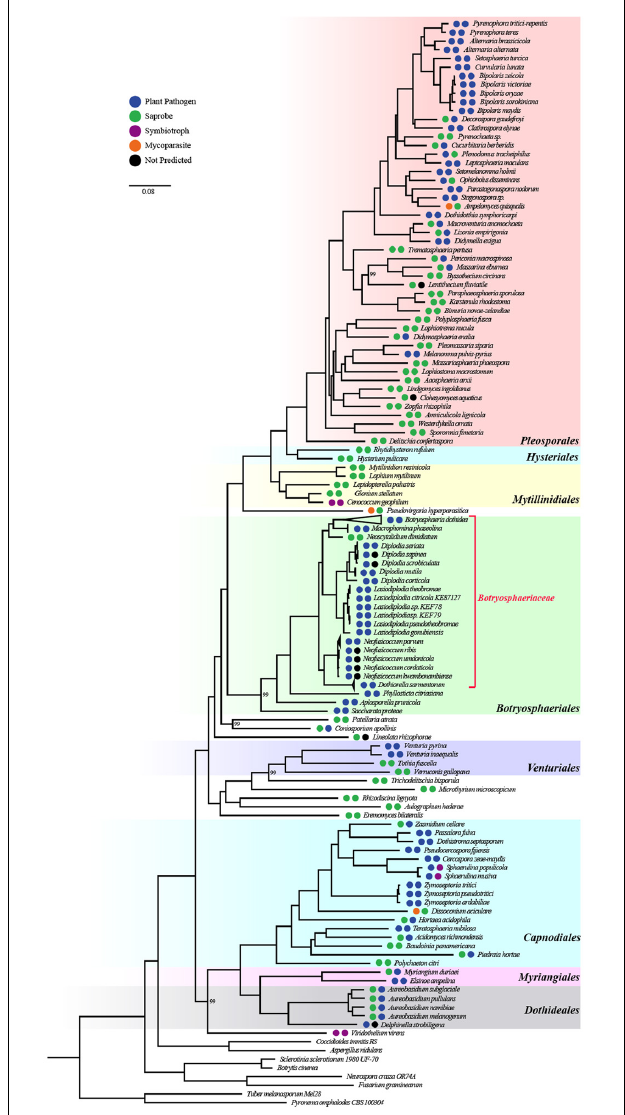
FIGURE 1 | Whole-genome-based phylogenetic tree of 271 species from Dothideomycetes and 8 outgroups. All bootstrap values are 100% except for those shown. The orders of Dothideomycetes were well classified and were displayed by different colors. The two circles left of species names standed for lifestyle classification according to organism data and FunGuild,